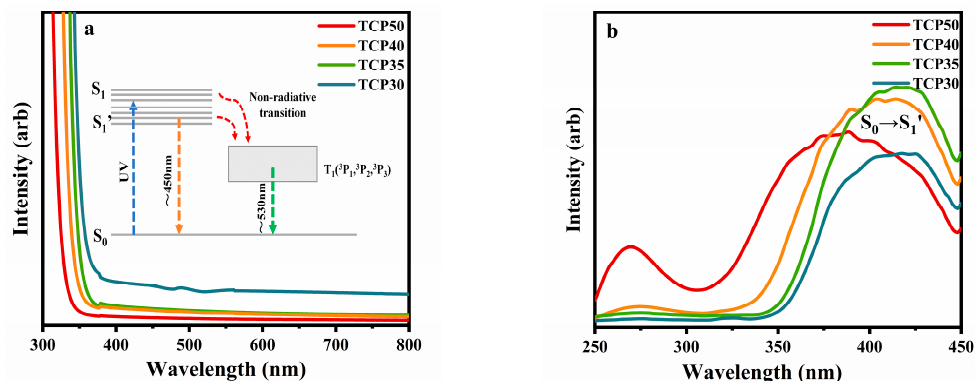
Figure 1. ( a ) Absorption spectra of TCP glasses, inset: Sn 2+ energy transfer model; ( b ) PLE spectra of TCP glasses under 530 nm excitation.